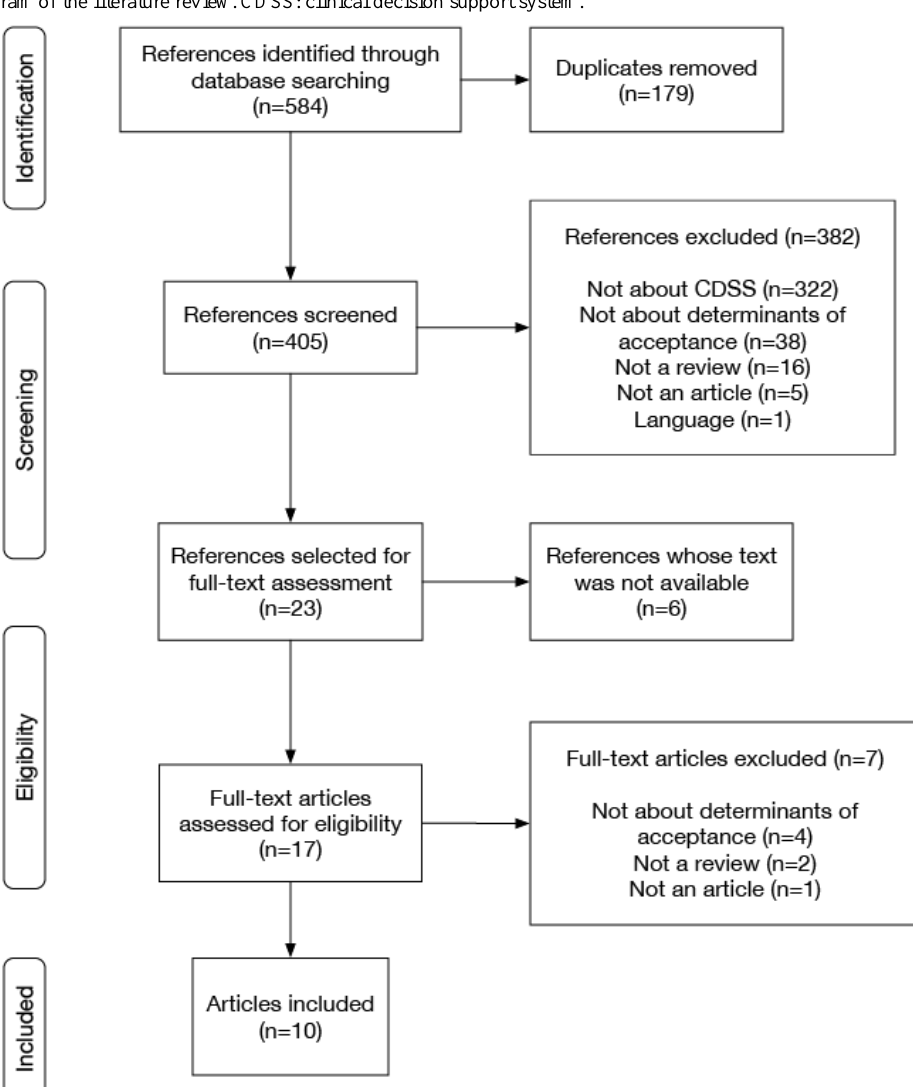
Figure 3. Flow diagram of the literature review. CDSS: clinical decision support